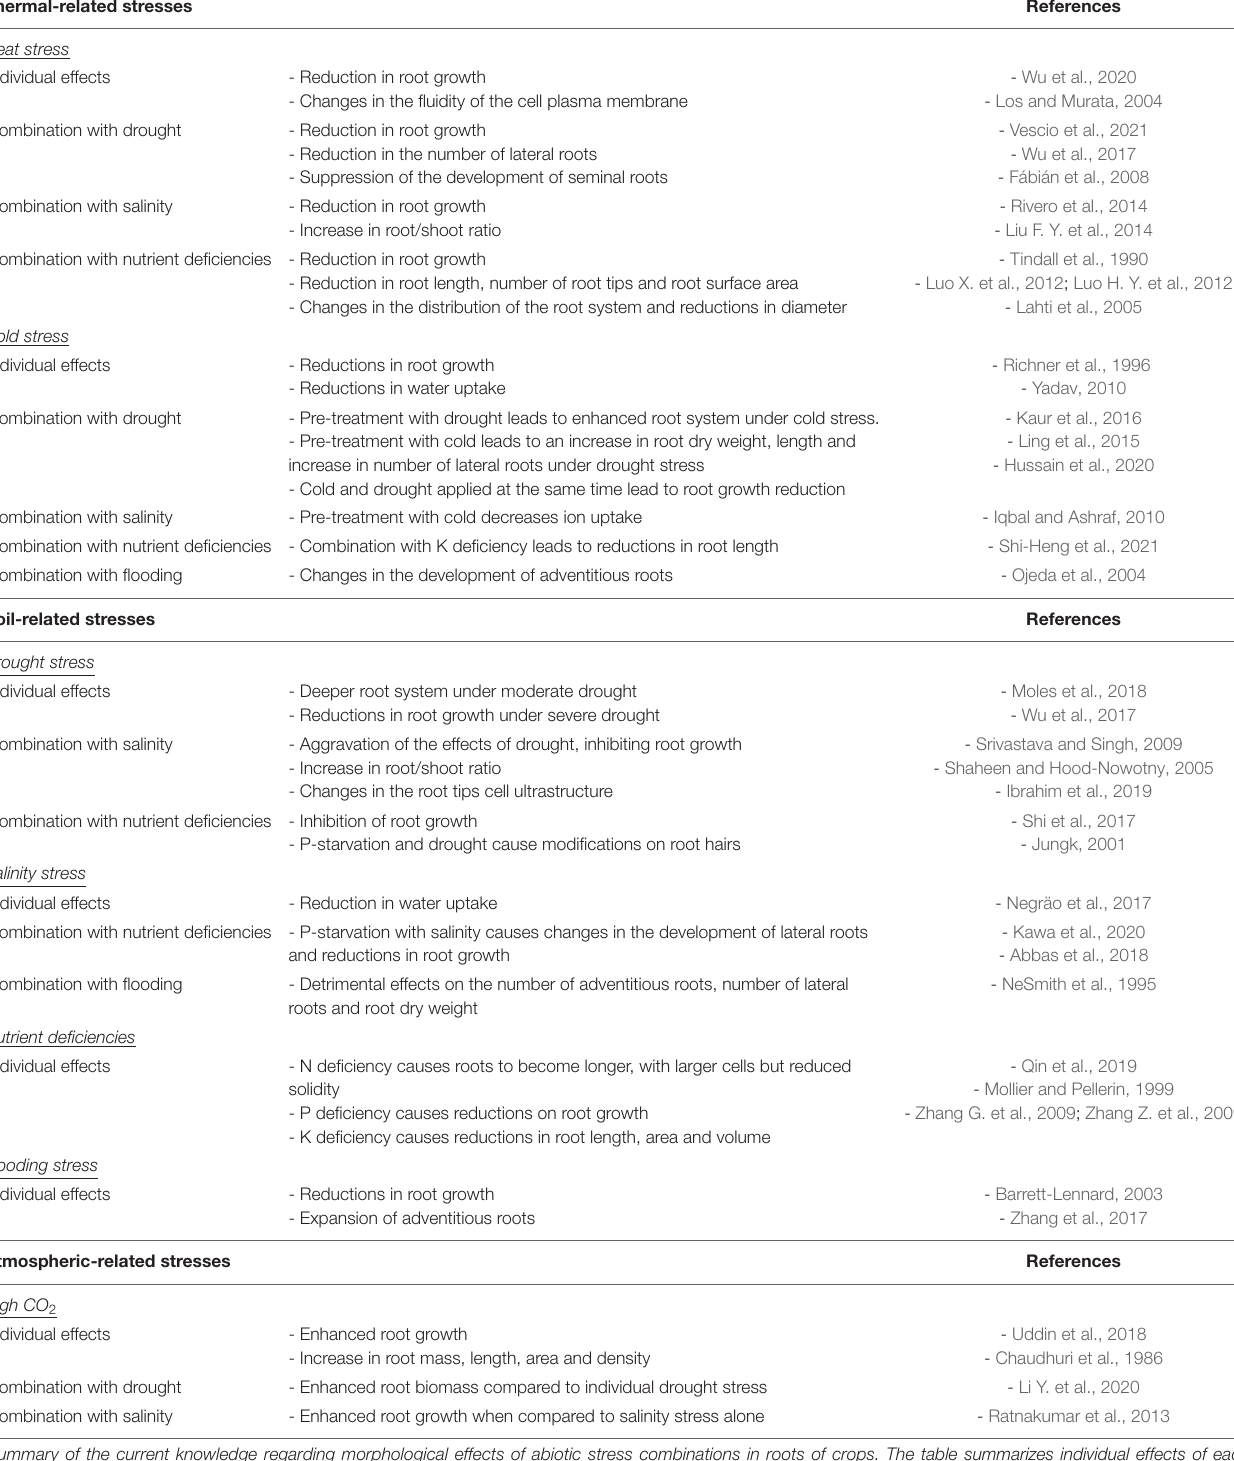
TABLE 1 | Individual effects of each stress and each abiotic stress combination in